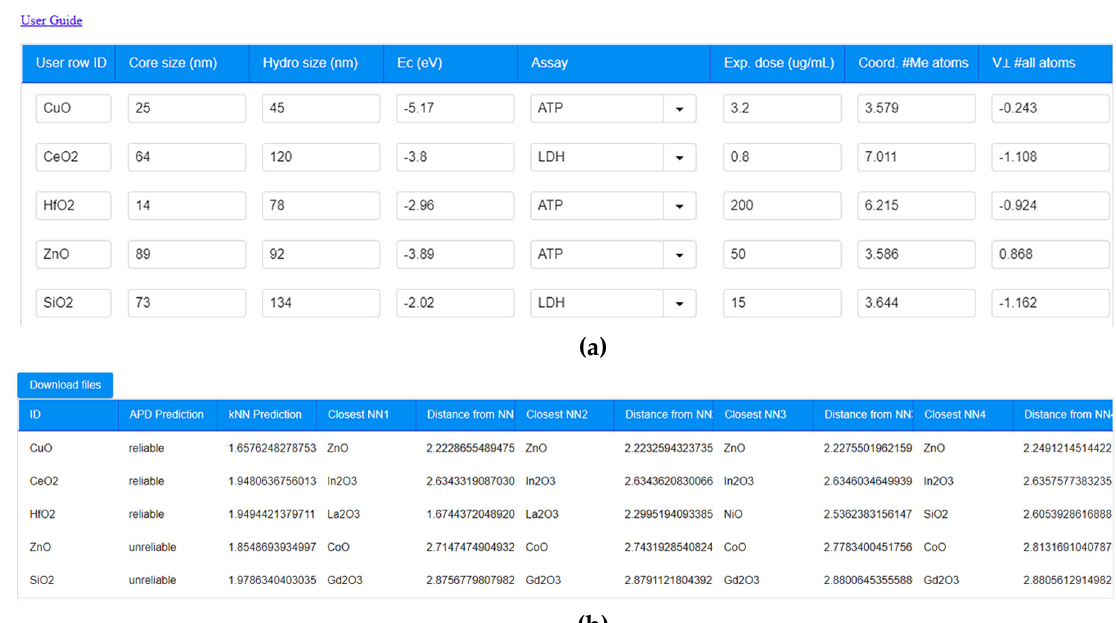
Figure 3. ( a ). Cell viability webservice for the prediction of Me x O y NP cytotoxicity. The user inputs the required parameters and the calculation is performed automatically. ( b ). The results provided from the webservice include the prediction, the distances of the closest neighbours and whether the prediction falls within the model’s domain of applicability (APD) (reliable prediction) or not (unreliable prediction).